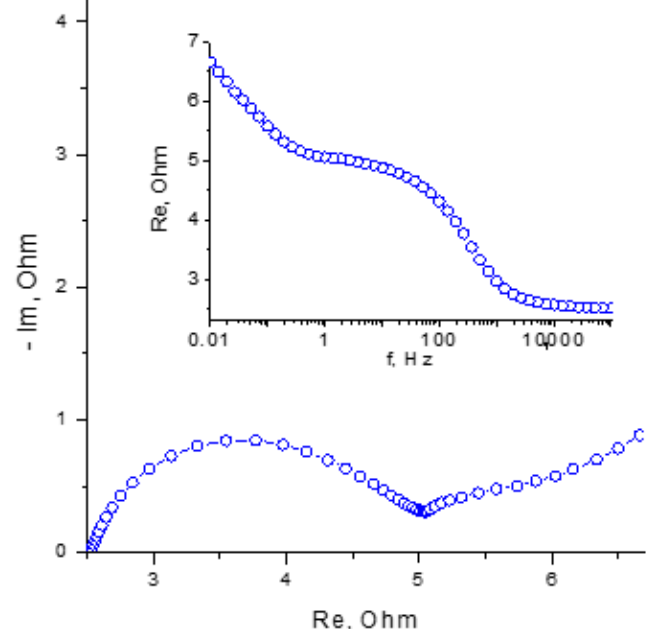
Figure 8. Nyquist diagram for charged cell 3 at 1720 mV in the frequency range from 10 kHz to 0.01 Hz. The inset shows the dependence of the real component of the impedance on the logarithm of the frequency (Bode diagram) in the range from 100 kHz to 0.01 Hz.